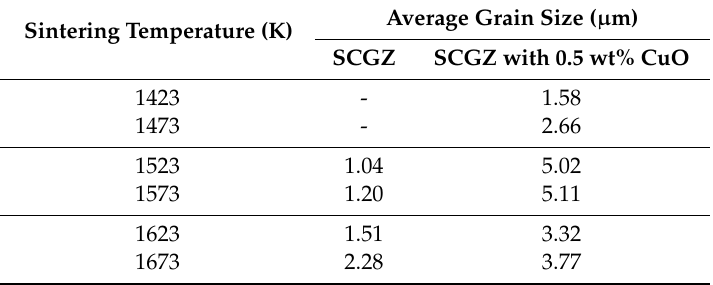
Figure 3 . SEM images of sintered SCGZ with 0 . 5 wt % CuO at ( a ) 1423 K, ( b ) 1473 K, ( c ) 1523 K, ( d ) Figure 3. SEM images of sintered SCGZ with 0.5 wt% CuO at ( a ) 1423 K, ( b ) 1473 K, ( c ) 1523 K, ( d ) 1573 K, 1573 K, ( e ) 1623 K and ( f ) 1673 K . ( e ) 1623 K and ( f ) 1673 K. Table 1. Average grain size of sinterted Sc 0.1 Ce 0.05 Gd 0.05 Zr 0.89 O 2 (SCGZ) electrolyte and sintered SCGZ Table 1 . Average grain size of sinterted Sc 0 . 1 Ce 0 . 05 Gd 0 . 05 Zr 0 . 89 O 2 (SCGZ) electrolyte and sintered SCGZ electrolyte with 0.5 wt% CuO when sintering temperature was varied. electrolyte with 0 . 5 wt% CuO when sintering temperature was varied . Average Grain Size ( µ Average Grain Size ( μ m ) Sintering Temperature (K) Sintering Temperature ( K )